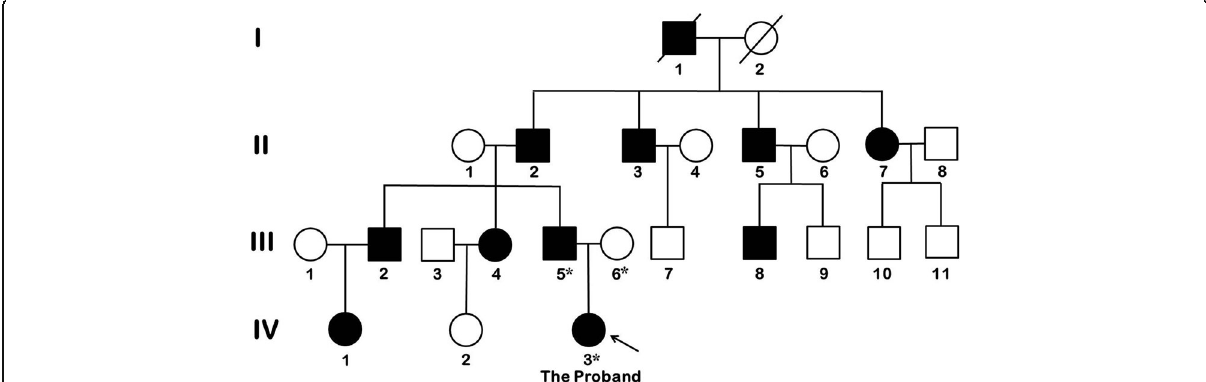
Fig. 1 Pedigree of the family enrolled in this study. Squares and circles represent males and females, respectively. Open and solid symbols indicate unaffected and affected individuals, respectively. Astericks indicate enrolled individuals. The proband, IV:3, is indicated with an arrow